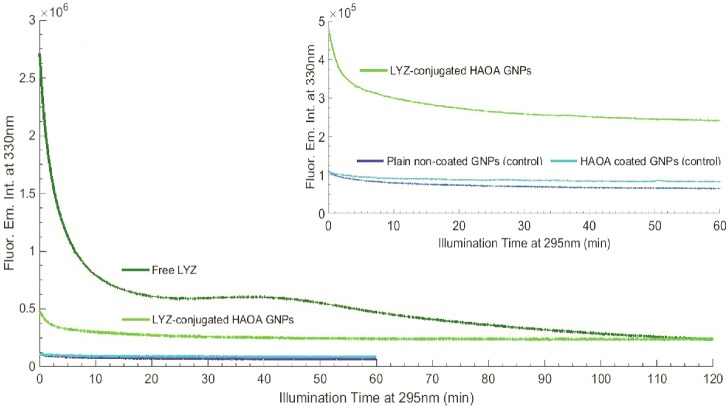
LYZ fluorescence emission intensity at 330 nm for free LYZ (2 h 295 nm excitation), LYZ-conjugated HAOA GNPs (2 h 295 nm excitation), and empty HAOA gold nanoparticles (GNPs) and non-coated plain GNPs (1h 295 nm excitation).All samples were analyzed at 20°C and excitation slit size fixed at 2.0 mm (4.4 μW). At the upper corner, LYZ-conjugated HAOA GNPs excited for 2 hours is compared to HAOA GNPs and plain GNPs.